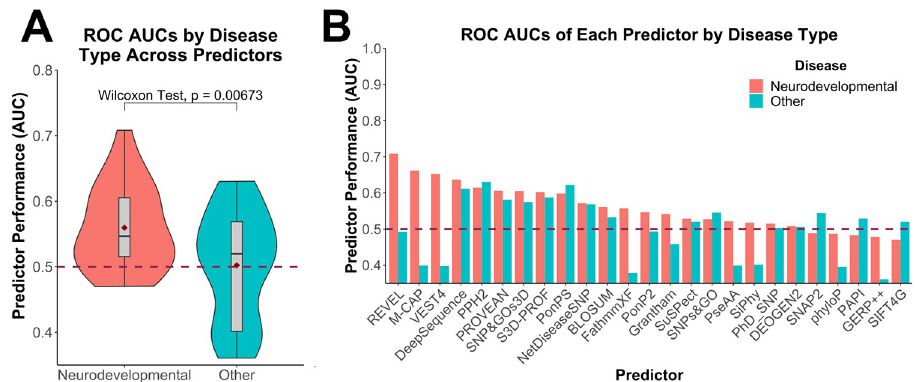
Fig 5. Comparison of VEP performance on pathogenic mutations in tubulin genes associated with neurodevelopmental vs other disease phenotypes. (A) Distribution of ROC AUC values across all VEPs for isotypes with mutations linked with neurodevelopmental or other disease phenotypes. The p-value stated was obtained via a paired Wilcoxon test. Maroon diamonds indicate the mean area. (B) ROC AUC values for each VEP in isotypes with mutations associated with neurodevelopmental or other disease phenotypes. Dashed line indicates the performance of a random predictor.